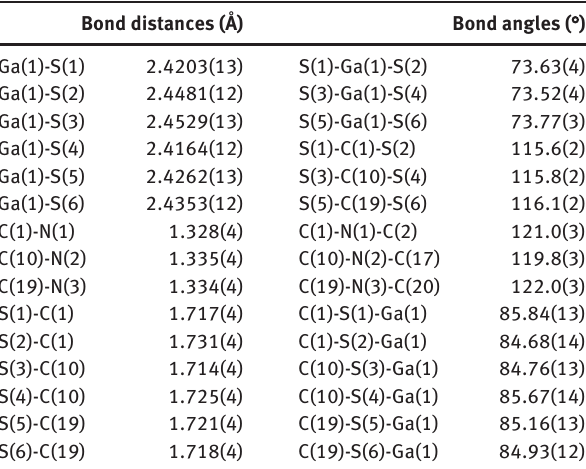
Table 2: Selected bond distances (Å) and bond angles ( ° ). Bond distances (Å) Bond angles ( °